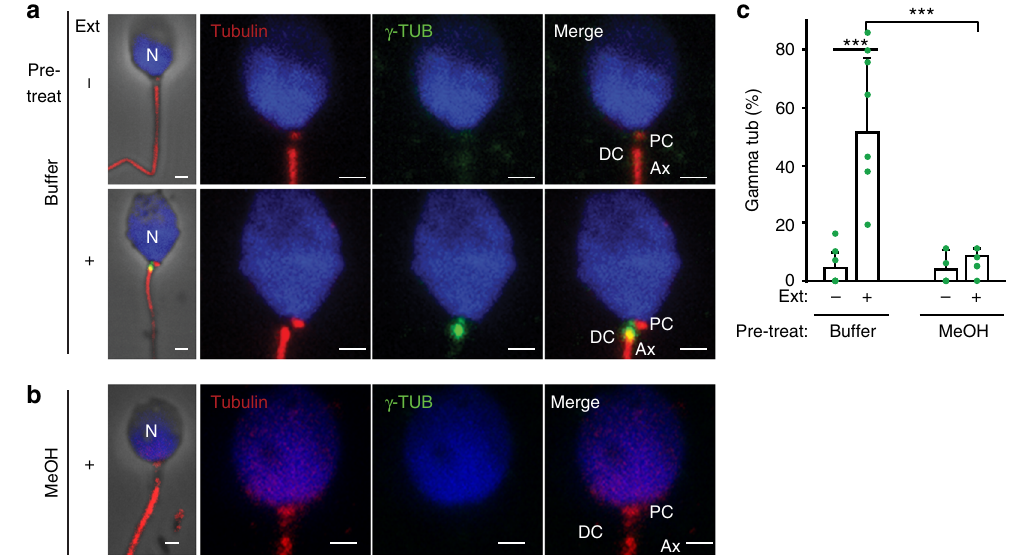
Fig. 5 The remodeled DC is functional in vitro. a – c The human remodeled DC recruits γ -tubulin from Xenopus egg extract. Demembranated human ejaculated spermatozoa did not have γ -tubulin, but after exposure to the extract, γ -tubulin was present near the DC ( a ). Demembranated spermatozoa with a DC inactivated by methanol pretreatment did not recruit γ -tubulin ( b ). Quanti fi cation ( N ≥ 3) of the percent of γ -tubulin-positive sperm pretreated with either buffer or methanol (MeOH) and then exposed to extract ( + ) or buffer ( − ) ( c ). p < 0.001 by t -test. Scale bar 1 μ m. Error bars represent